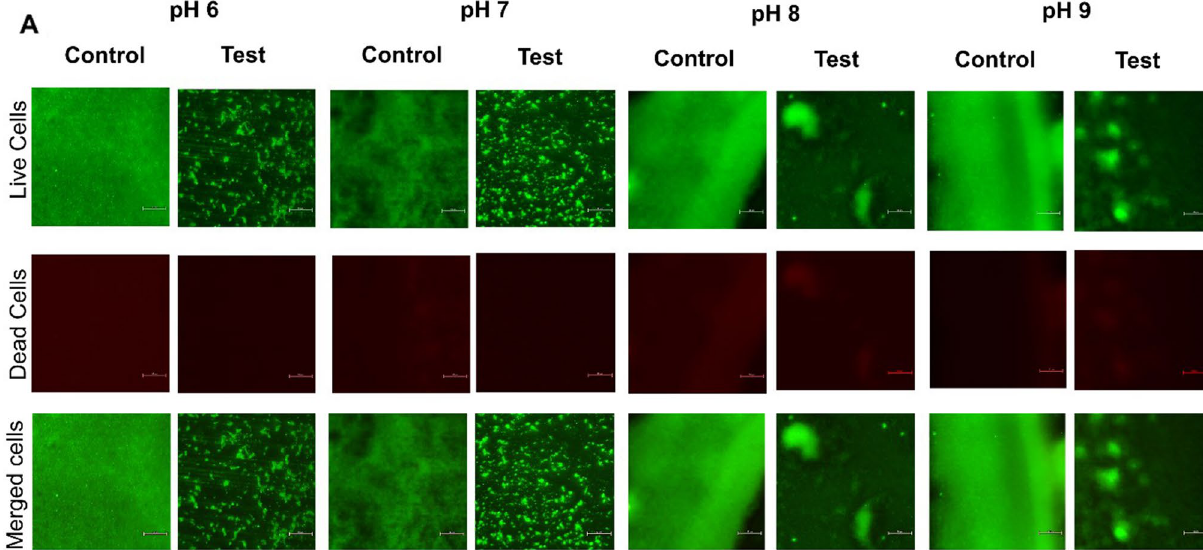
Figure 9. Fluorescent microscopy images of the biofilm formed by V. cholerae MTCC 3905 in the CAP-2M4VP treated (Test) and untreated (Control) conditions incubated statically for 24 h at 37 °C. At pH 6, pH 7, pH 8 and pH 9, the biofilms formed by V. cholerae MTCC 3905 upon treated with 31.25 μg/mL of CAP-2M4VP nano- formulation was minimal compared to the biofilm formed in the untreated (control) condition.